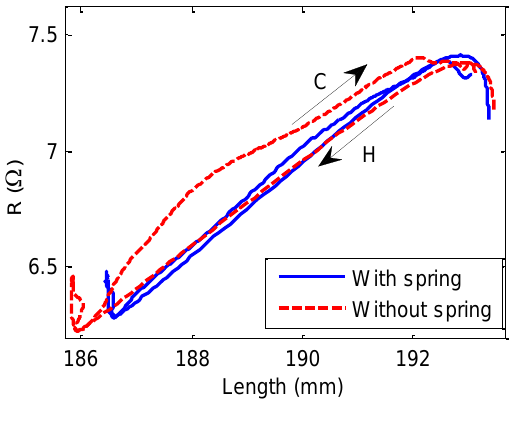
Figure 11. Experimental results of R-L relationships under constant (without spring) and variable (with spring) loads.